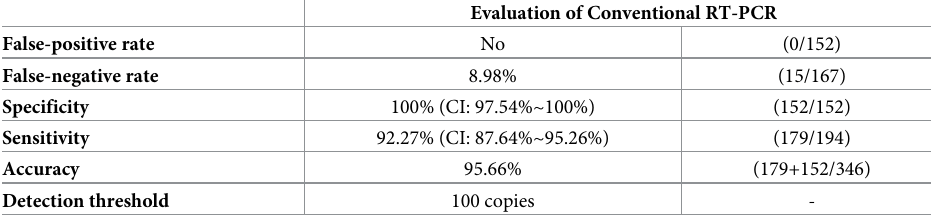
Table 2. Calculations of the validation parameters of classical RT-PCR in relation to the qPCR for